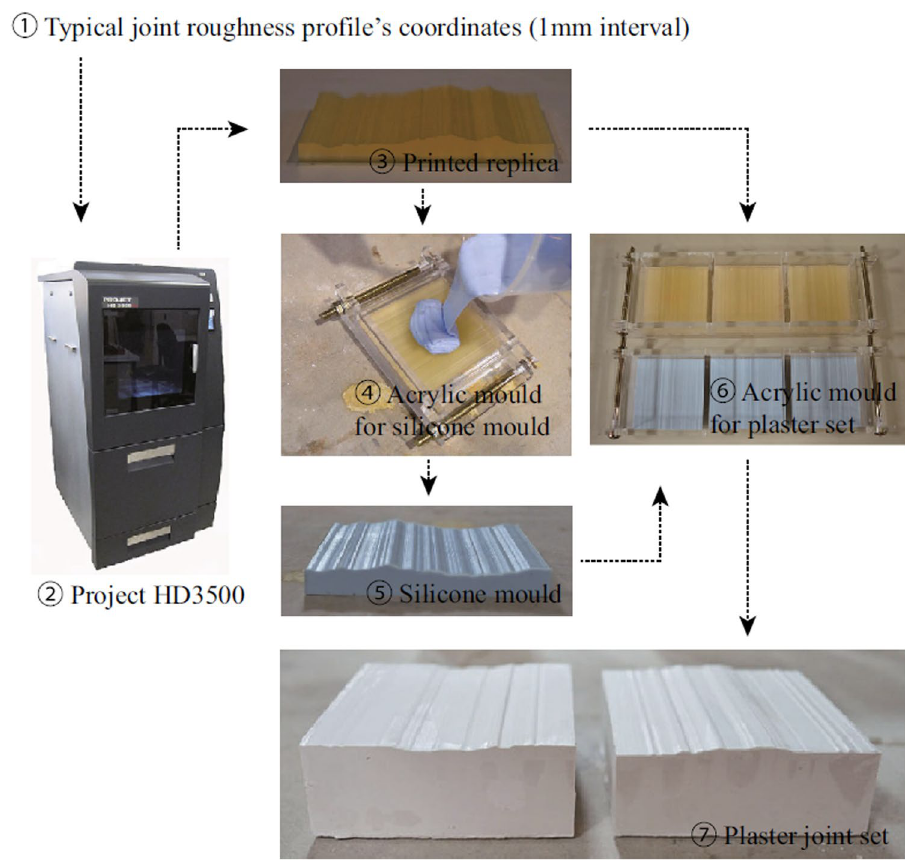
Fig. 1 3D printed plaster model with Barton’s joint profile (Kim et al. 2016)